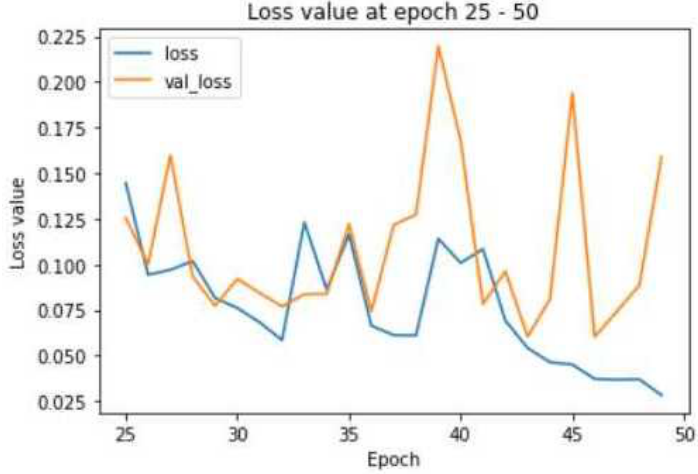
Figure 7. Evaluation of the loss and validation loss in VGG16.